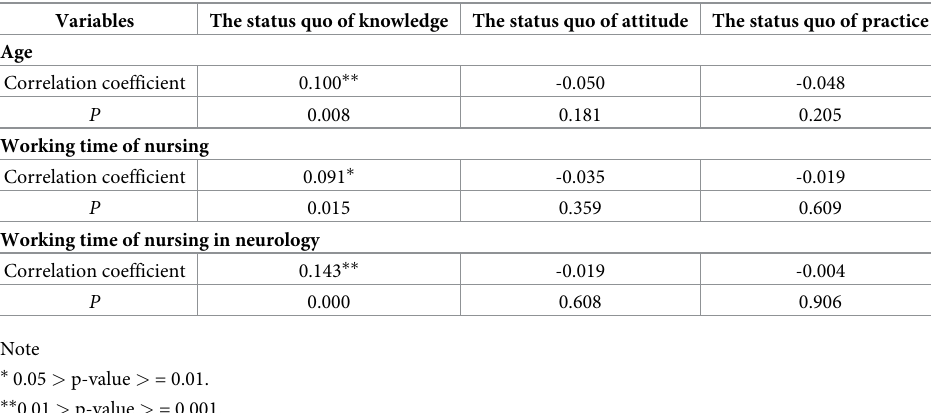
Table 2. Factors associated with the status of KAP (continuous